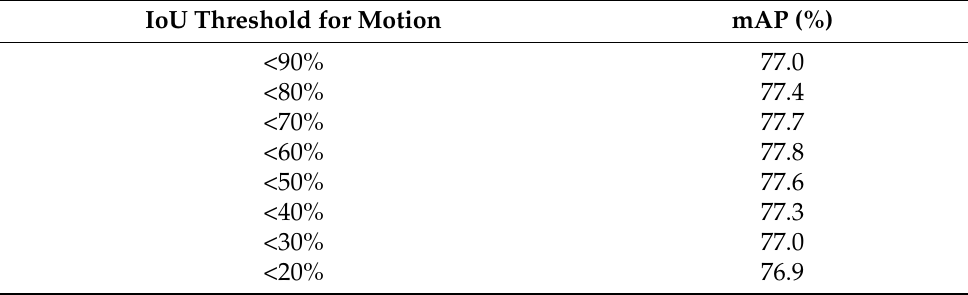
Table 4. Performance comparison using various IoU thresholds for large motion.